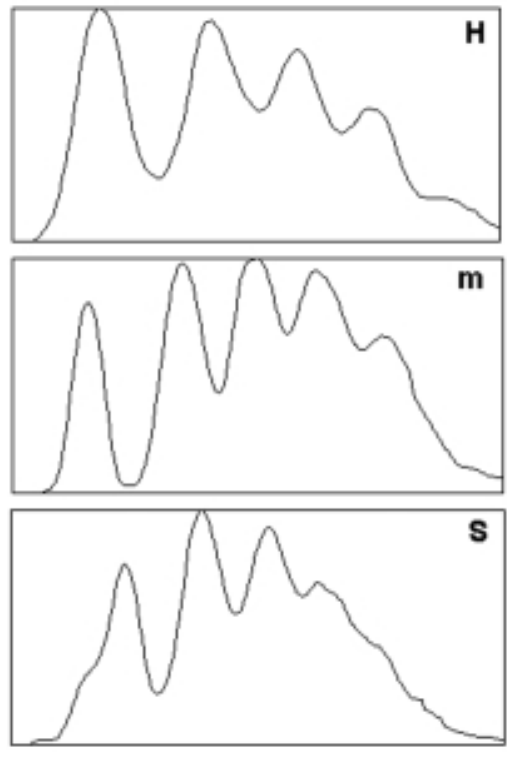
Fig. 2 – Typical densitometry profile for each organ (H - Hunter, m - main, S- Sachs) of E. electricus , obtained from the average images of isoelectricfocusing gels (left = basic, right =